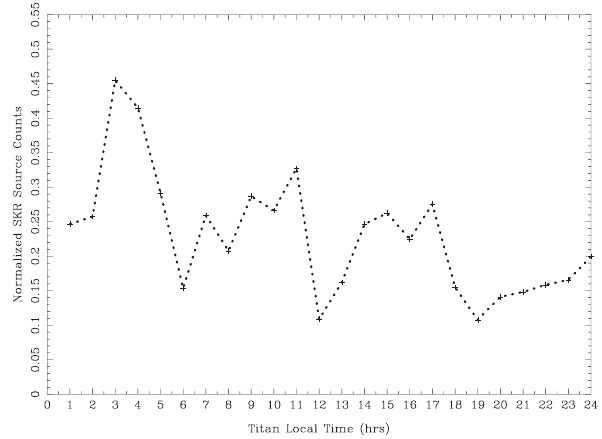
Figure 7b Fig. 7b. The same as Fig. 7a, except that we calculate the average of all 1-h bins of SKR source LT over the range of 00:00h to 05:00h, thus including nightside sources only. Now the most significant peak occurs for a Titan LT near